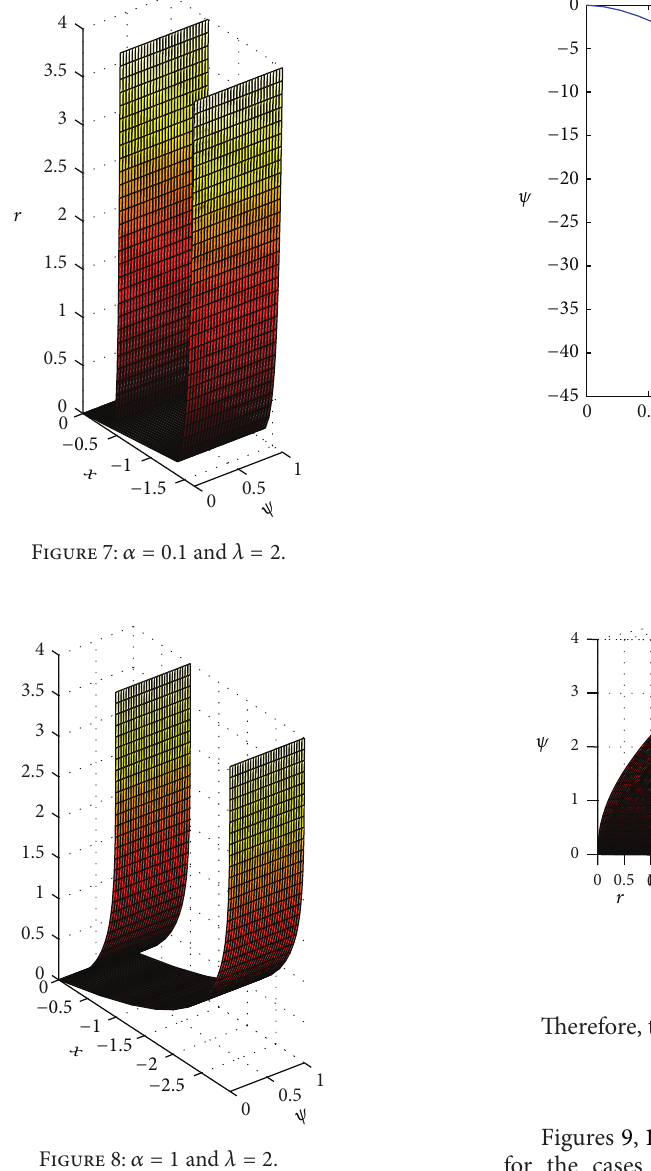
Figure 8: 𝛼 = 1 and 𝜆 = 2 .